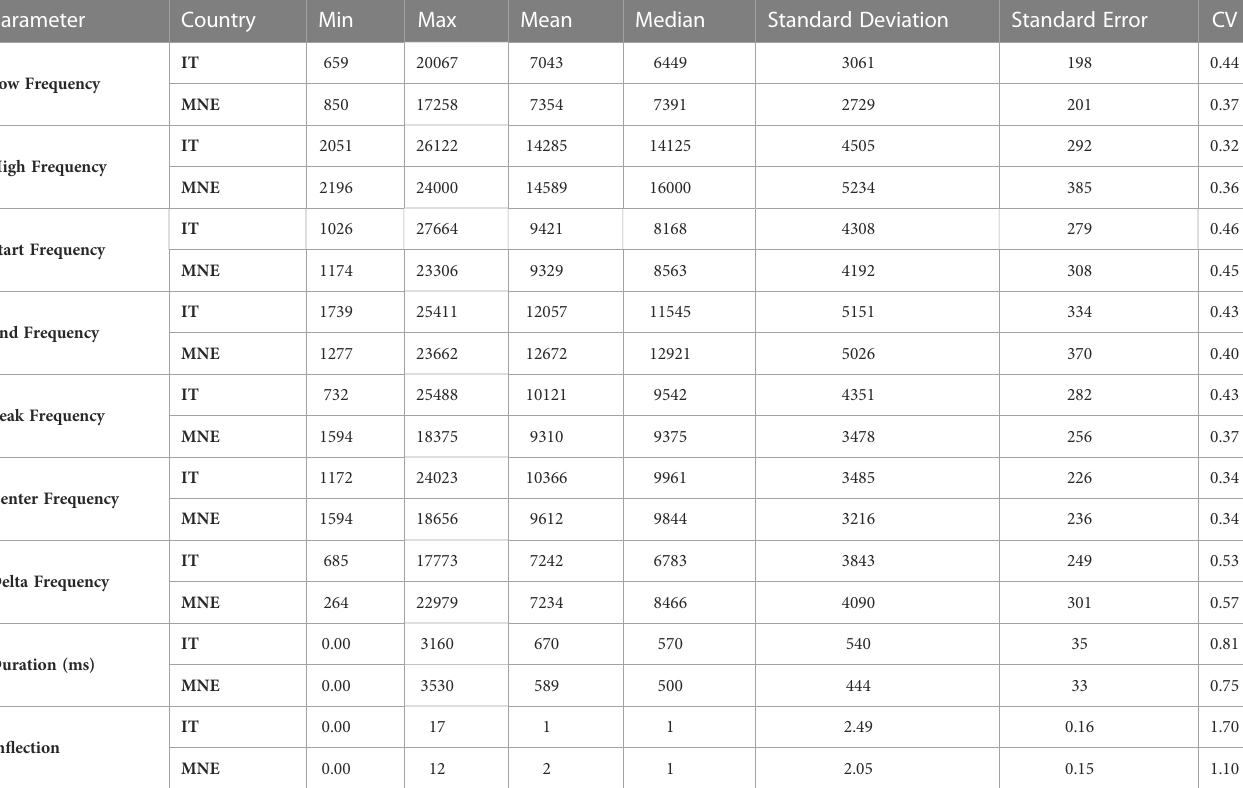
TABLE 3 Summary statistics of whistles produced in Taranto Gulf, Italy (denoted by IT) and Boka Bay, Montenegro (denoted by MNE). Parameter